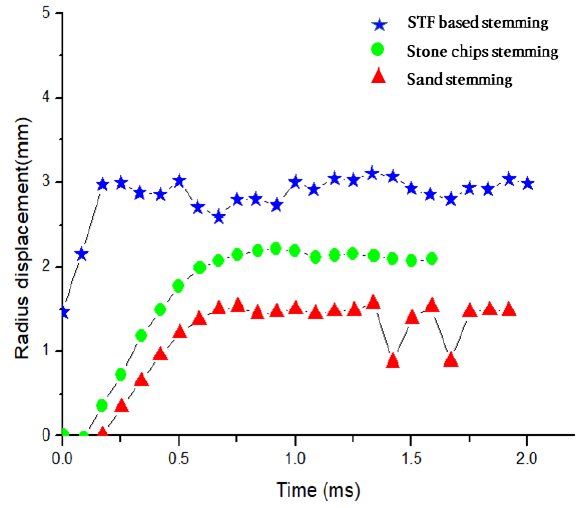
Figure 14. Radial displacement of the lead block at the surface of the lower blast hole with setting time after detonation.